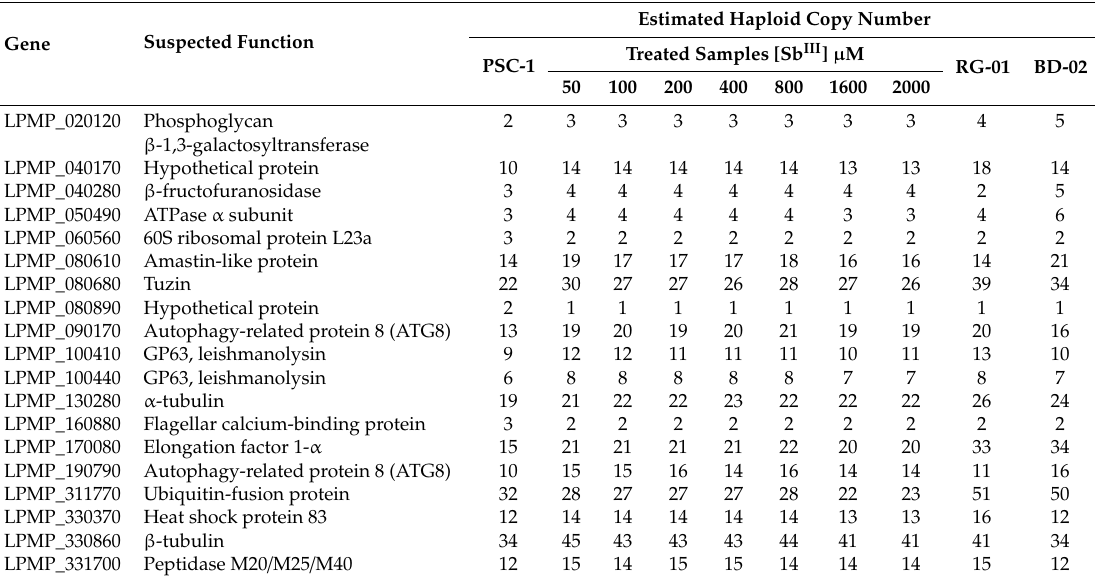
Table 1. Protein-coding genes with di ff erent haploid copy number estimates among the samples included in this study 1